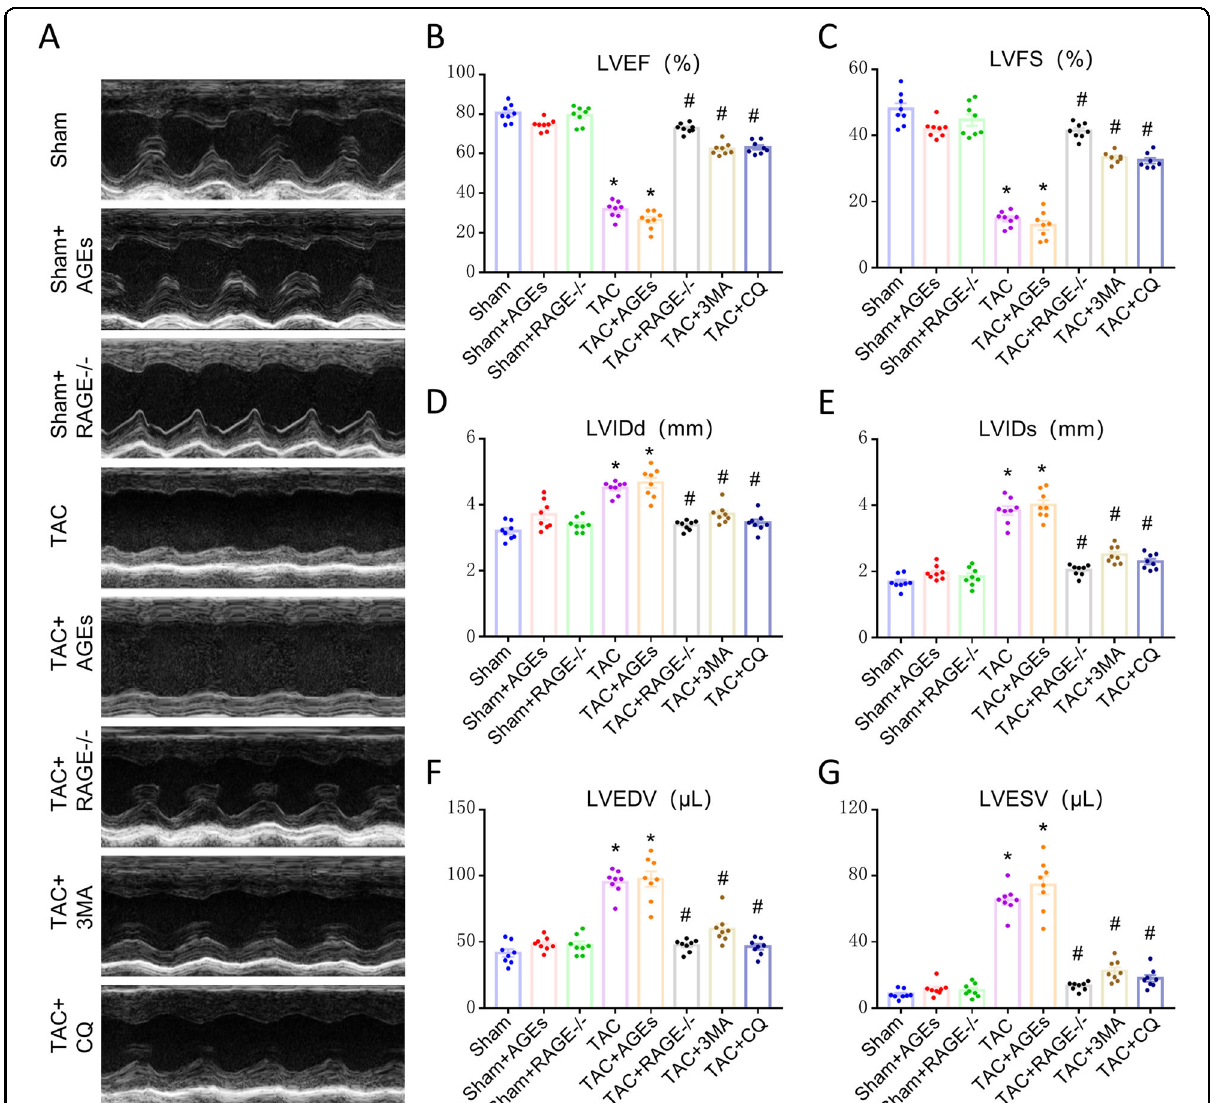
Fig. 1 Improvement of cardiac function at 8 weeks after TAC by genetic deletion of RAGE or an autophagy inhibitor (3-MA or CQ). A Representative M-mode images. Echocardiography was performed to measure LVEF ( B ), LVFS ( C ), LVIDd ( D ), LVIDs ( E ), LVEDV ( F ), and LVESV ( G ). n = 8. Data are presented as mean ± SEM. * p < 0.05 vs. sham group, # p < 0.05 vs. TAC